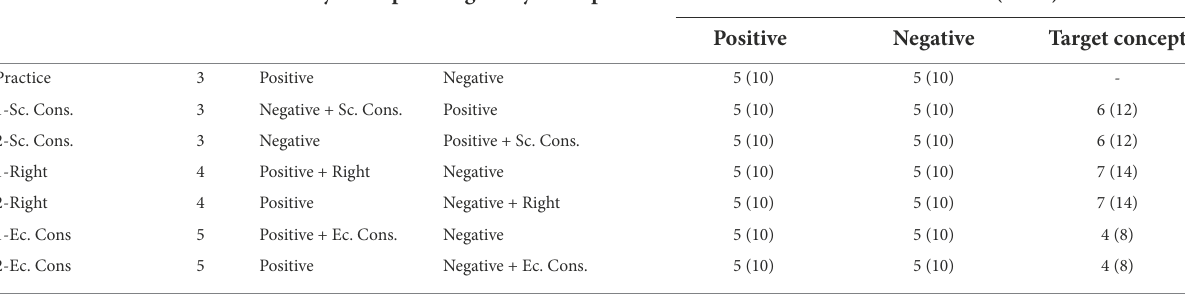
TABLE 1 Concept assignment, stimulus, and trial proportions across ST-IAT parts. Part of IAT Block Left key